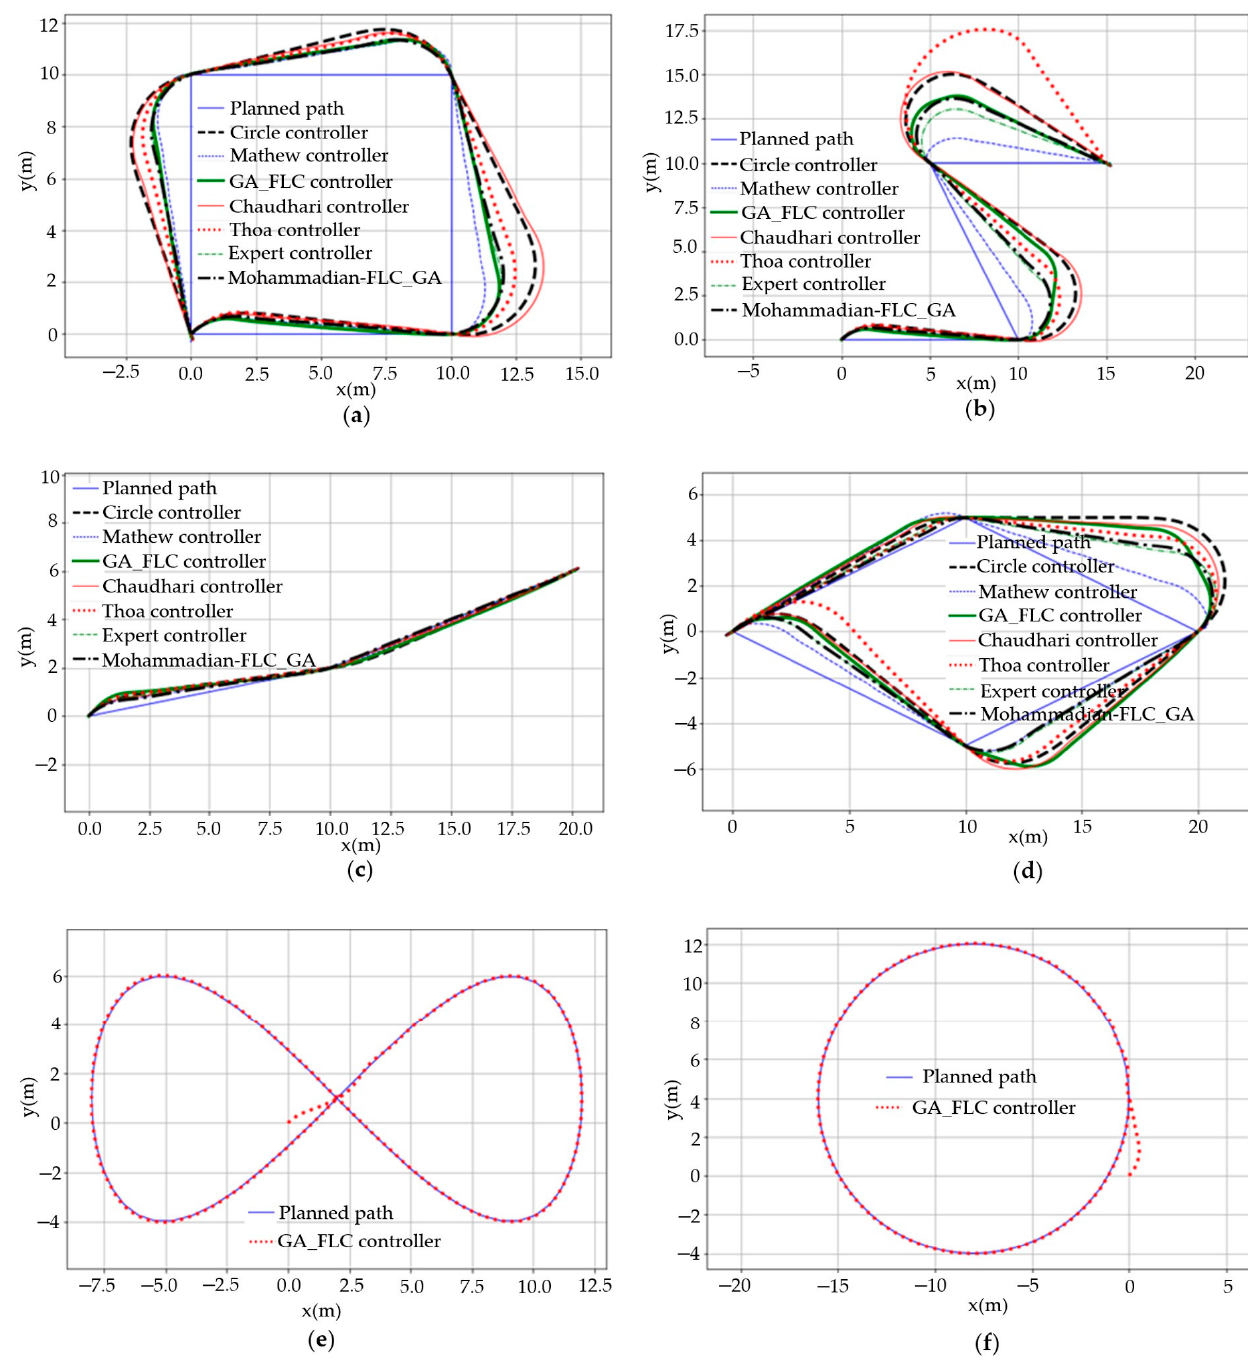
Figure 15. Analysis of the simulation results for the other paths. ( a ) The square path tracking of the robot; ( b ) The sharp turn path tracking of the robot; ( c ) The straightforward path tracking of the robot; ( d ) The diamond-shaped path tracking of the robot; ( e ) The number eight-shaped path tracking of the robot when it is controlled by the GA_FLC; ( f ) The circle path tracking of the robot when it is controlled by the GA_FLC.